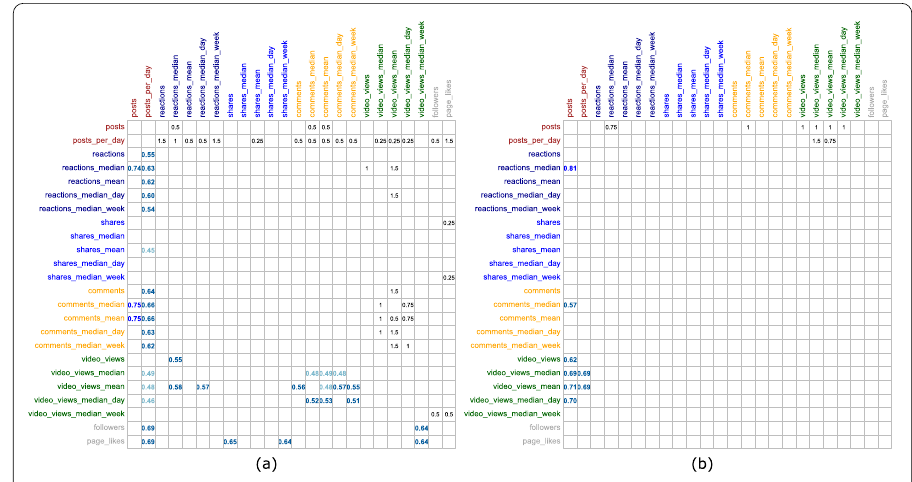
Figure 6 Cross-validated linear regression models. ( a ) Ideology models, ( b ) Polarization